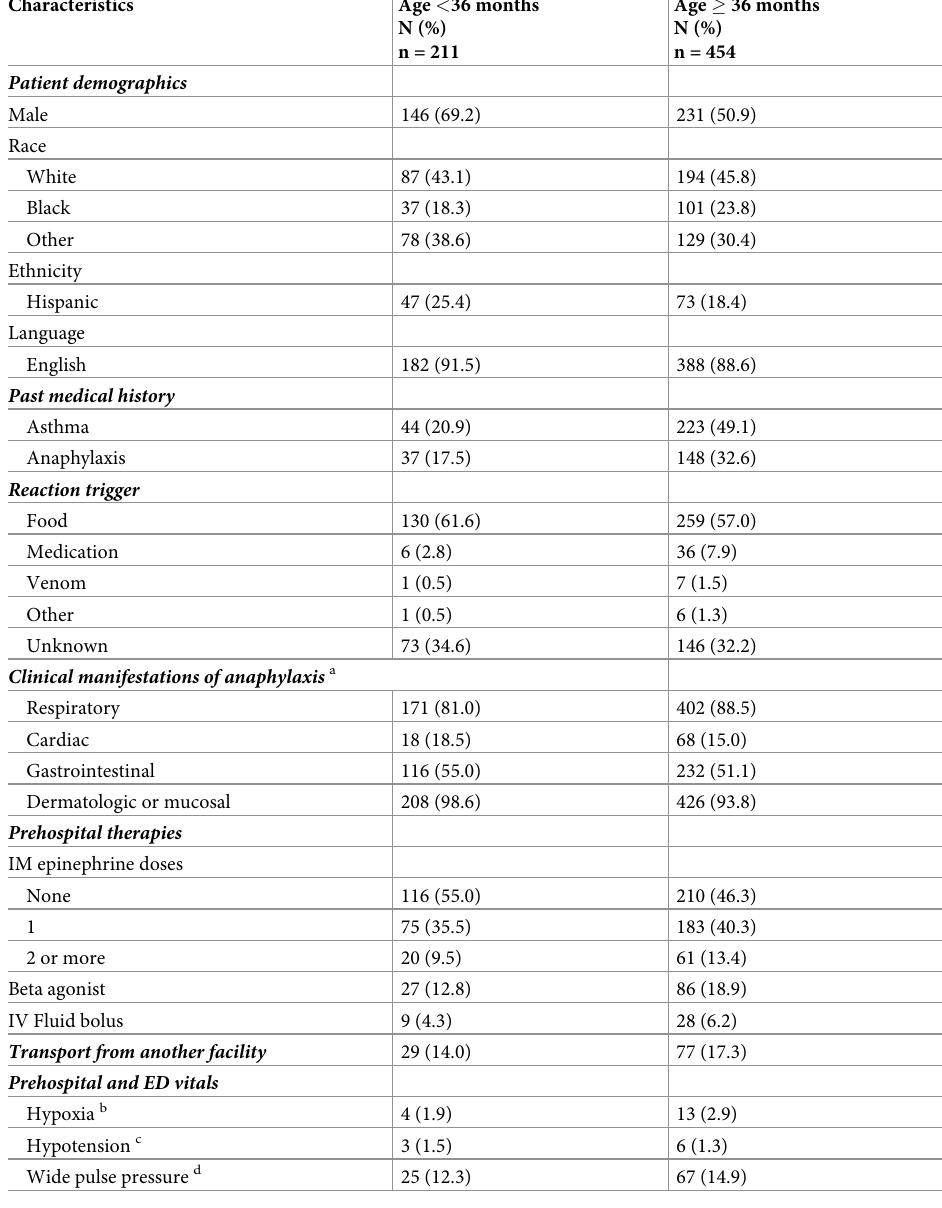
Table 1. Characteristics of children hospitalized with